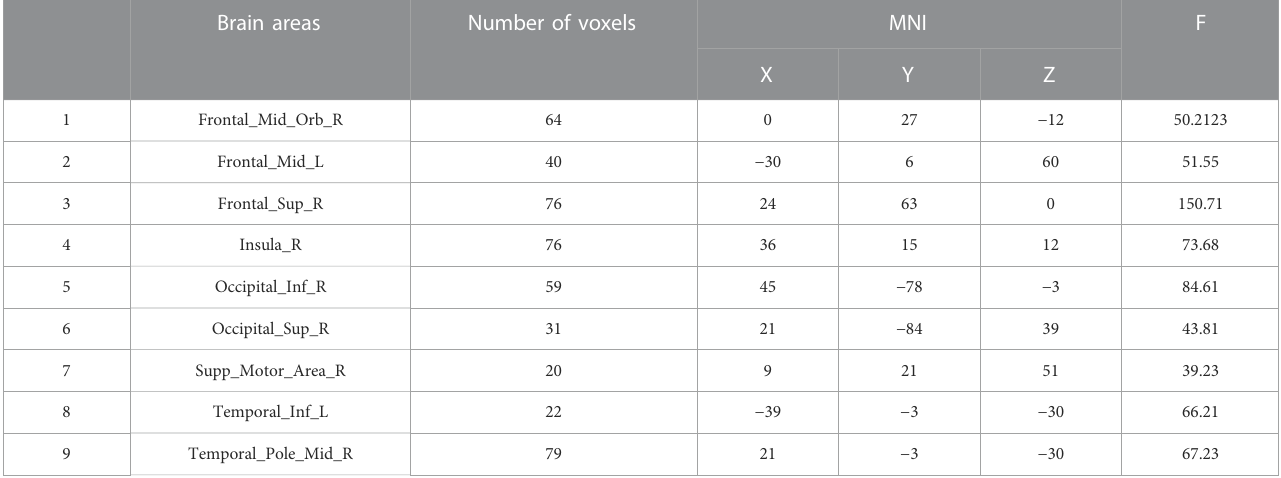
TABLE 4 Comparison of the fALFF values between the two groups after the intervention. Brain areas